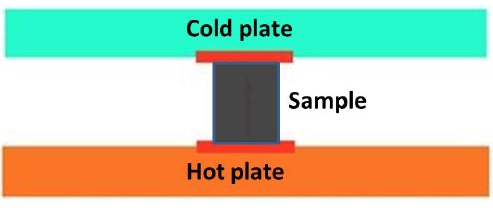
Figure 8. Schematic diagram of the thermal conductivity